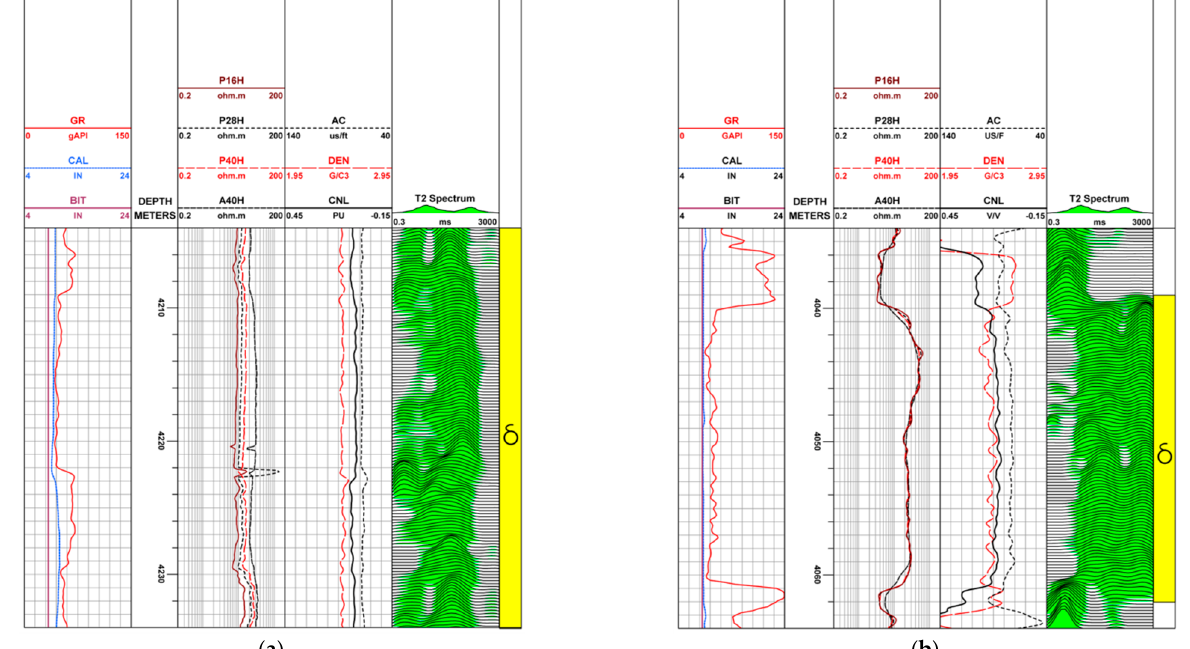
Figure 3. NMR logging response in different mud environments: ( a ) Water-based mud well A; ( b ) Oil-based mud well B.